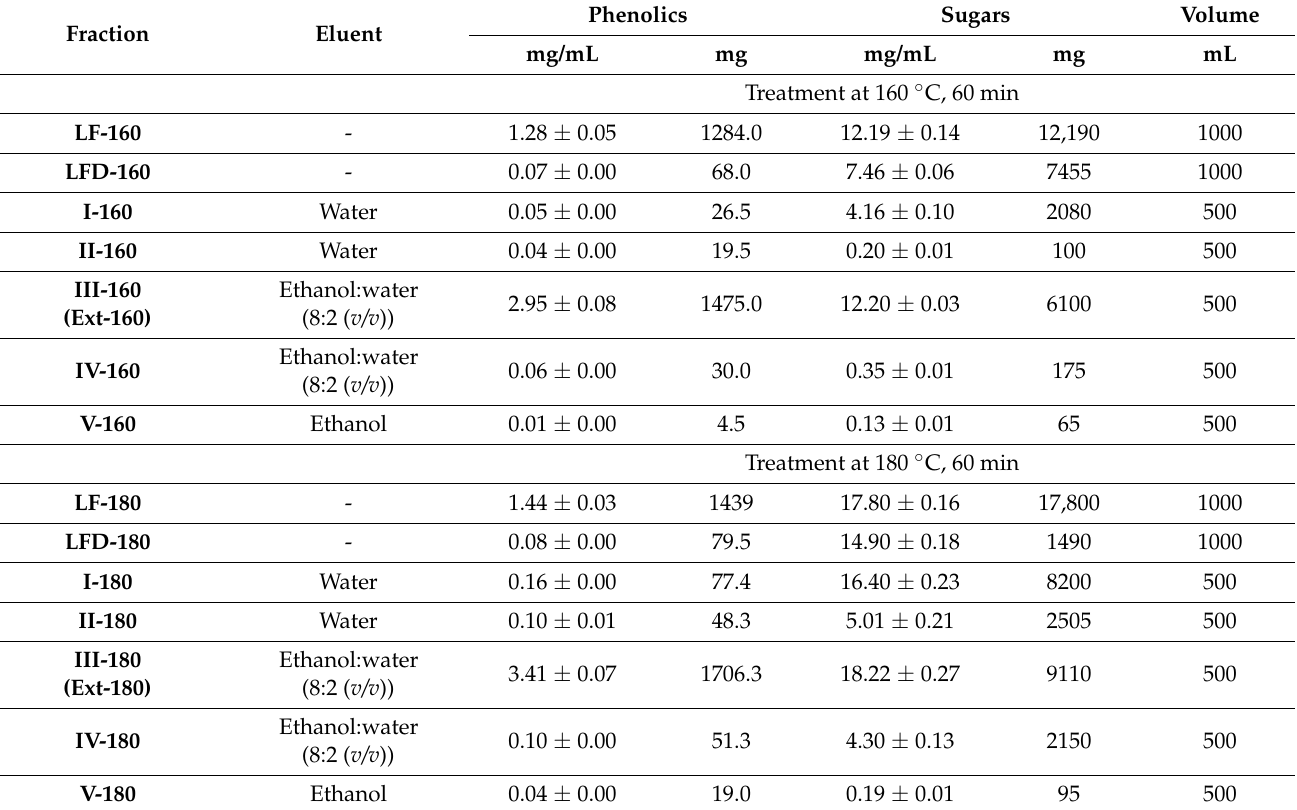
Table 1. The amounts of phenols and total sugars loaded and eluted from the adsorption chromato- graphic column to obtain a phenol-rich extract using the two liquid fractions obtained after the treatment of date seeds at 160 and 180 ◦ C for half an hour. Values are mean ±